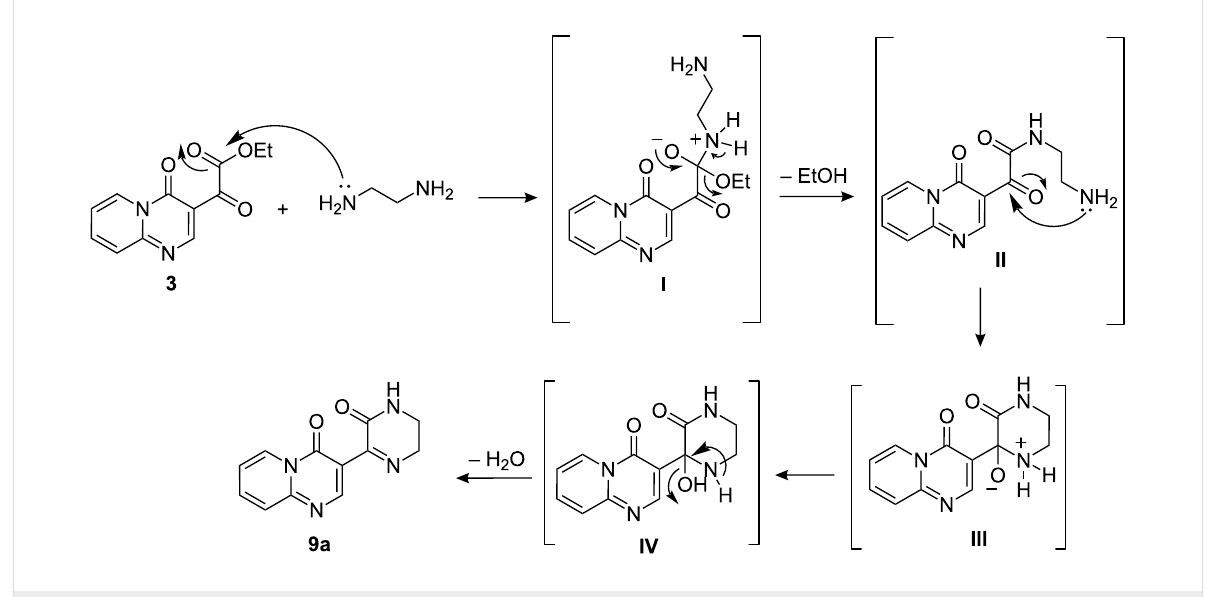
Scheme 2: Mechanism proposed for the formation of compound 9a .